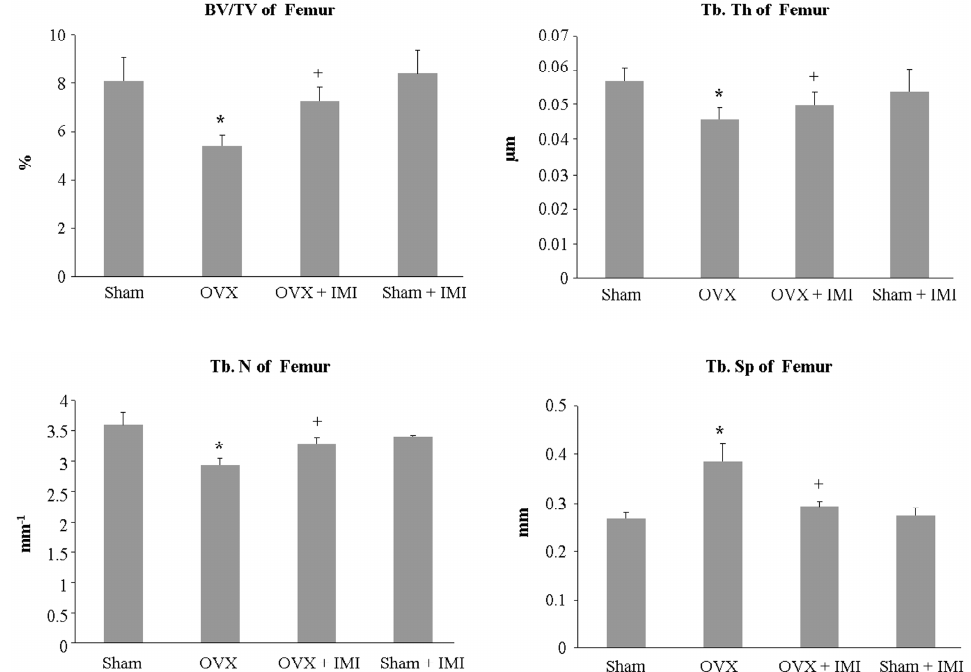
Figure 7. Micro-CT analysis of bone structural parameters. Bone volume (BV/TV, bone volume over tissue volume), trabecular number (Tb.N), trabecular thickness (Th.Th), and trabecular separation (Tb.Sp) were evaluated. Each bar represents the mean ± standard deviation of eight mice. Statistical significance determined by two-way ANOVA is designated as follows: * p < 0.05 versussham group; + p < 0.05 versus OVX group.